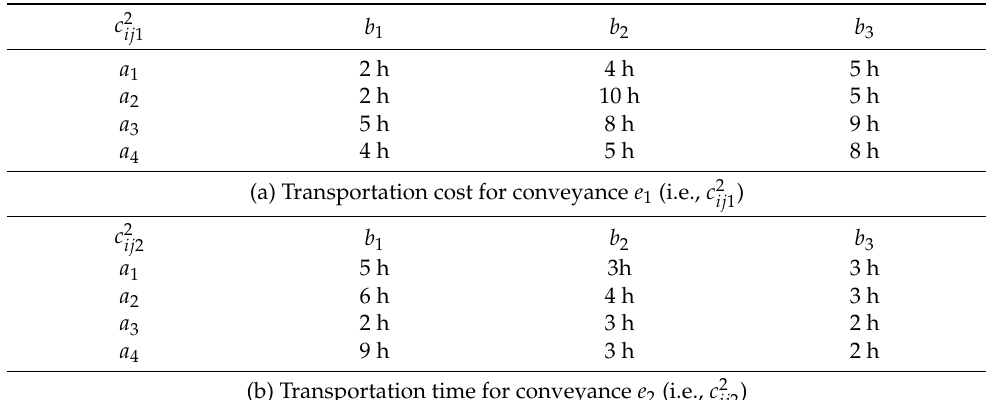
Table 3. Transportation